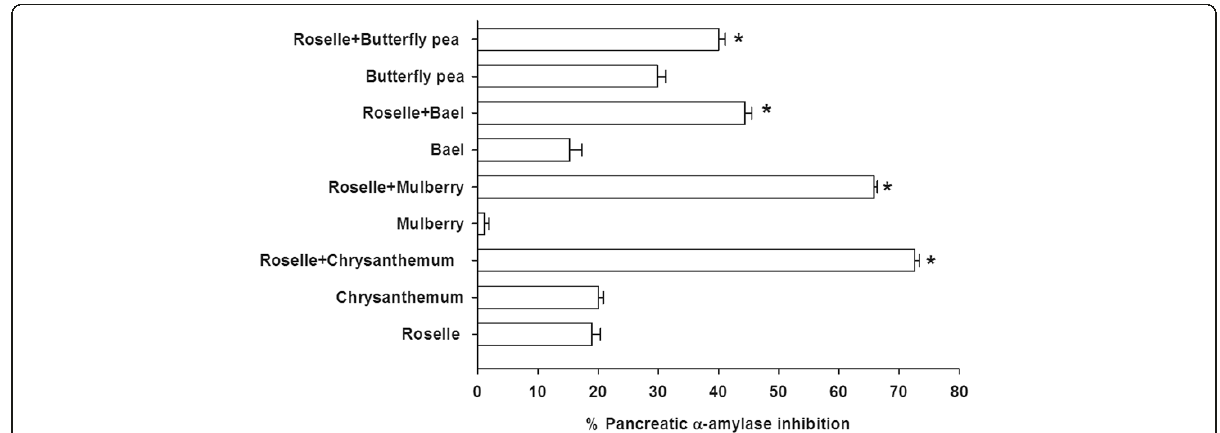
Figure 4 The percentage pancreatic α -amylase of combinatorial plant-based foods (2.0 mg/ml) with roselle (2.0 mg/ml). Results are expressed as means ± S.E.M., n=3. *P < 0.001 compared to roselle